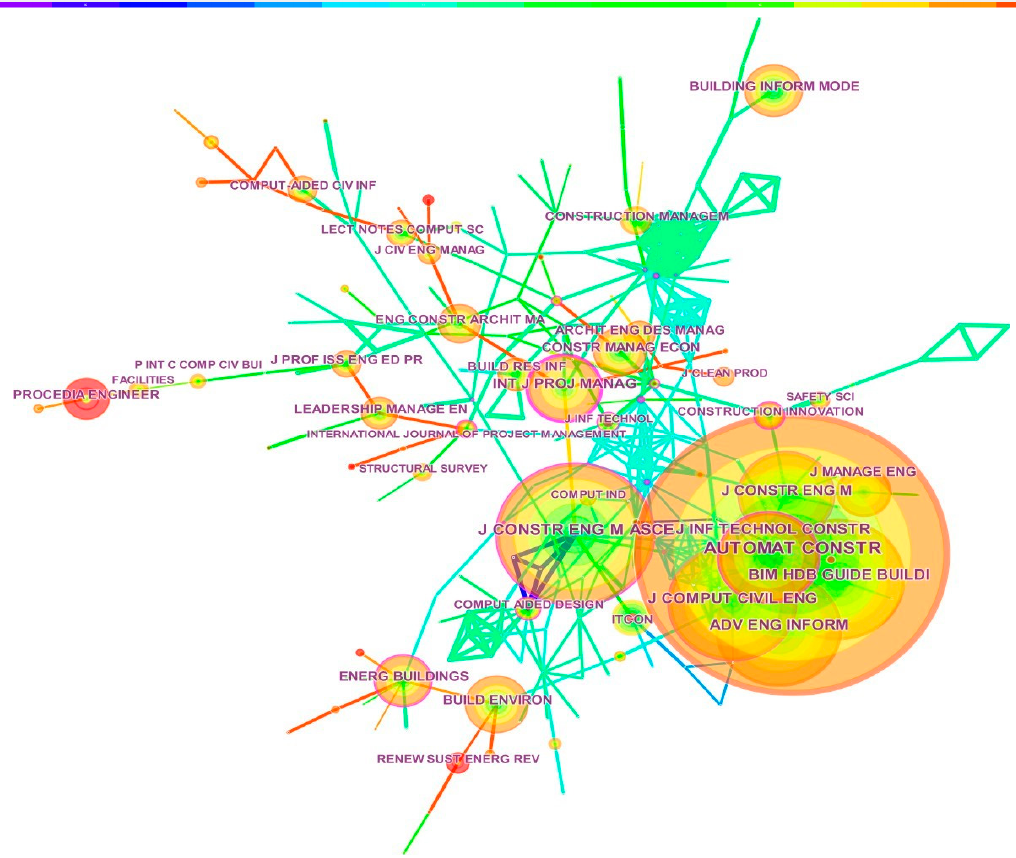
Figure 10. Journal co-citation